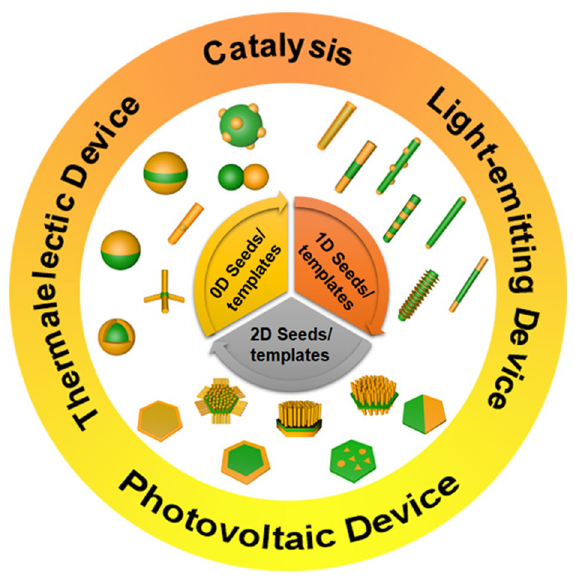
Fig. 1 Schematic illustration of epitaxial heterostructures based on 0D seeds/templates, 1D seeds/templates, and 2D